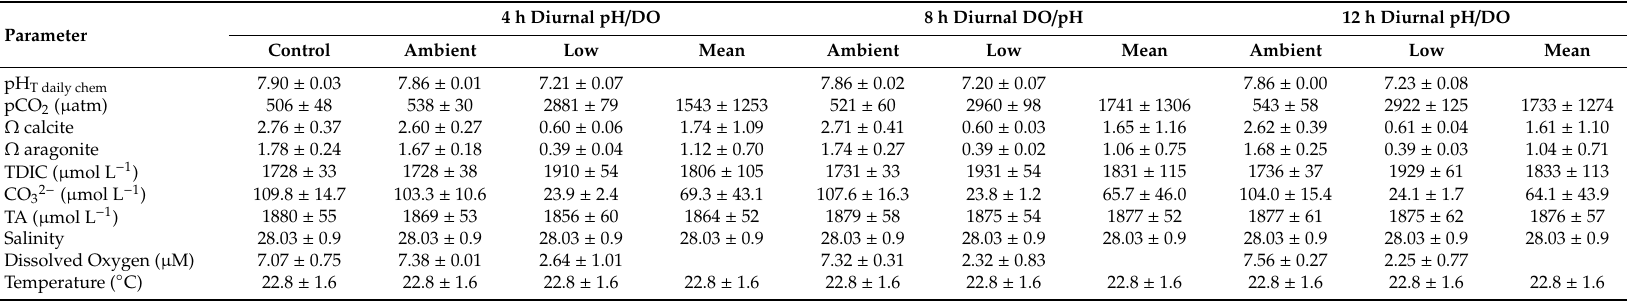
Table 7. Mean ( ± standard deviation) pH, pCO 2 , saturation states of calcite and aragonite, total dissolved inorganic carbon (TDIC), carbonate, total alkalinity (TA), salinity, dissolved oxygen, and temperature for the Menidia beryllina II four treatment diurnal duration acidification and hypoxia experiments. 4 h Diurnal pH / DO 8 h Diurnal DO / pH 12 h Diurnal pH / DO Parameter Control Ambient Low